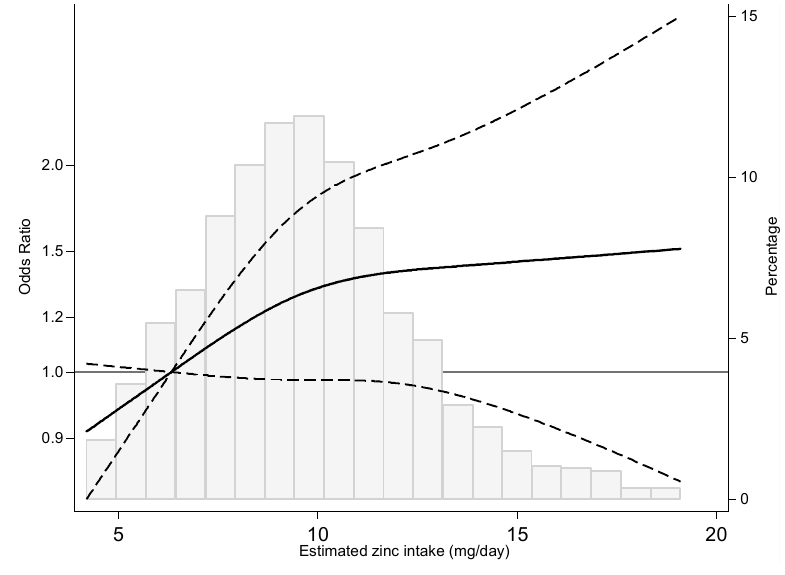
Figure 1. Prostate cancer odds ratio by estimated dietary zinc intake. OR (solid line) and 95% CIs (dashed lines) by estimated zinc intake modelled by using restricted cubic splines for zinc concentrations with knots at the 10th, 50th, and 90th percentile. The reference value is set at the 30th percentile of the zinc distribution. OR were adjusted for age, education, BMI, family history of prostate cancer, calcium intake and grains and legumes consumption as fixed effects, and province of residence as a random effect.